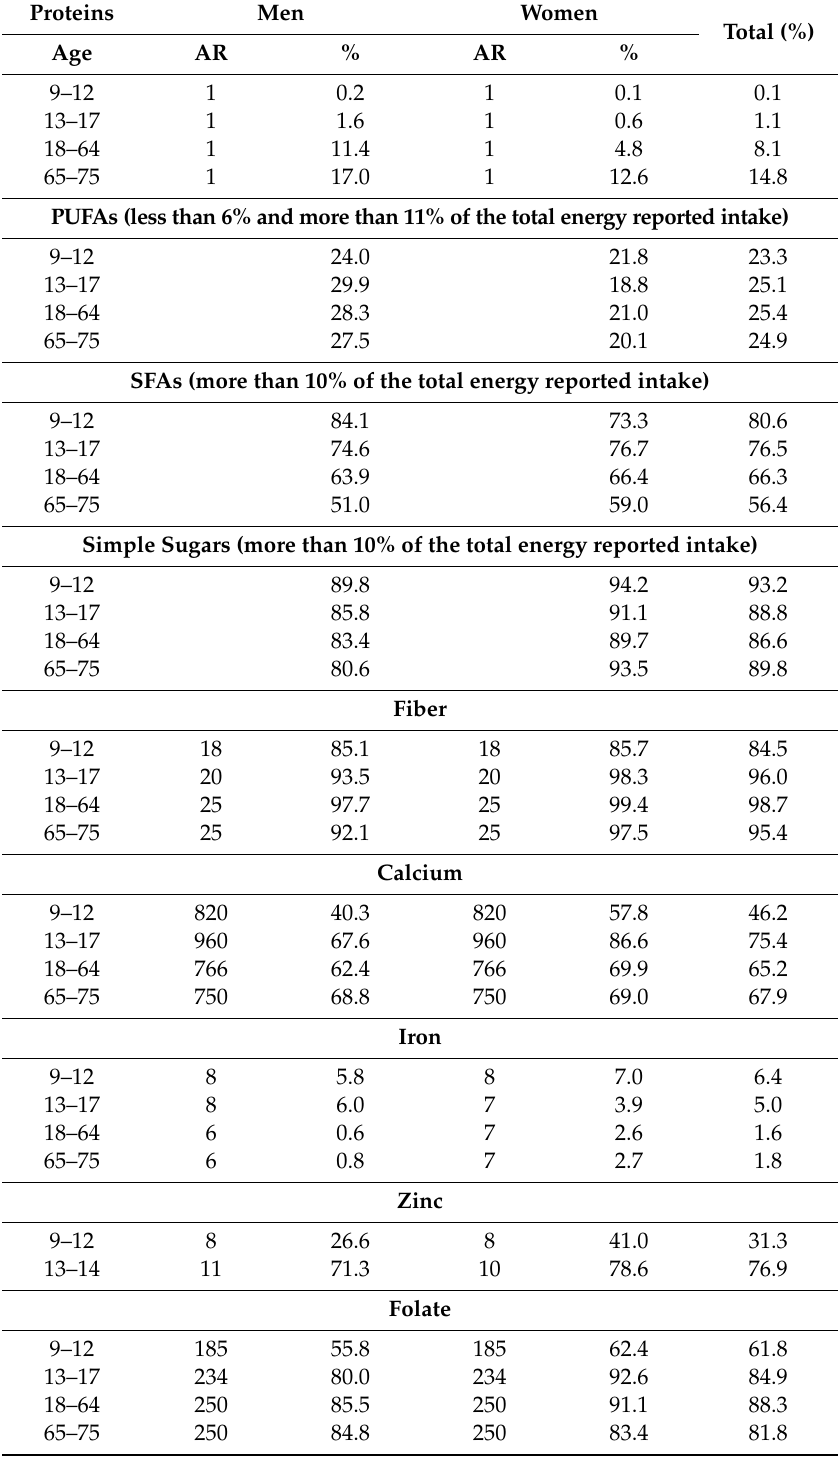
Table 3. Percentage of the ANIBES population not meeting adequate intake recommendations for critical nutrients, stratified by age and